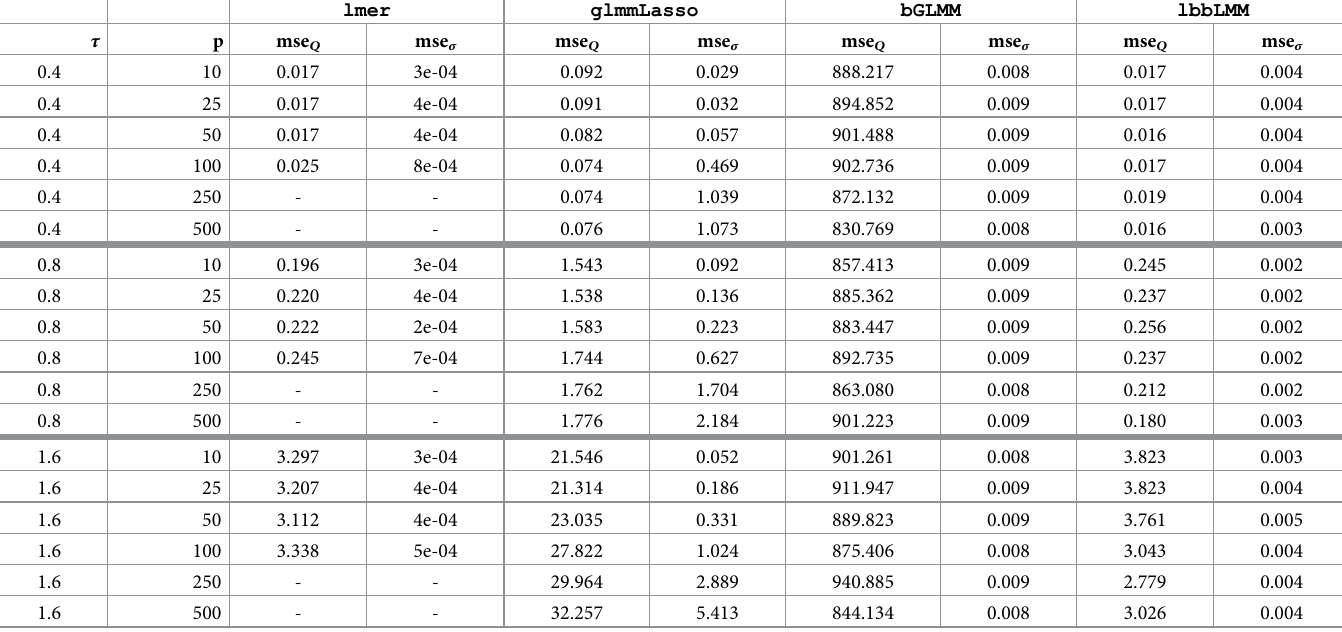
Table 5. Median mse Q and mse σ of 100 independent simulation runs for each random slopes setup.